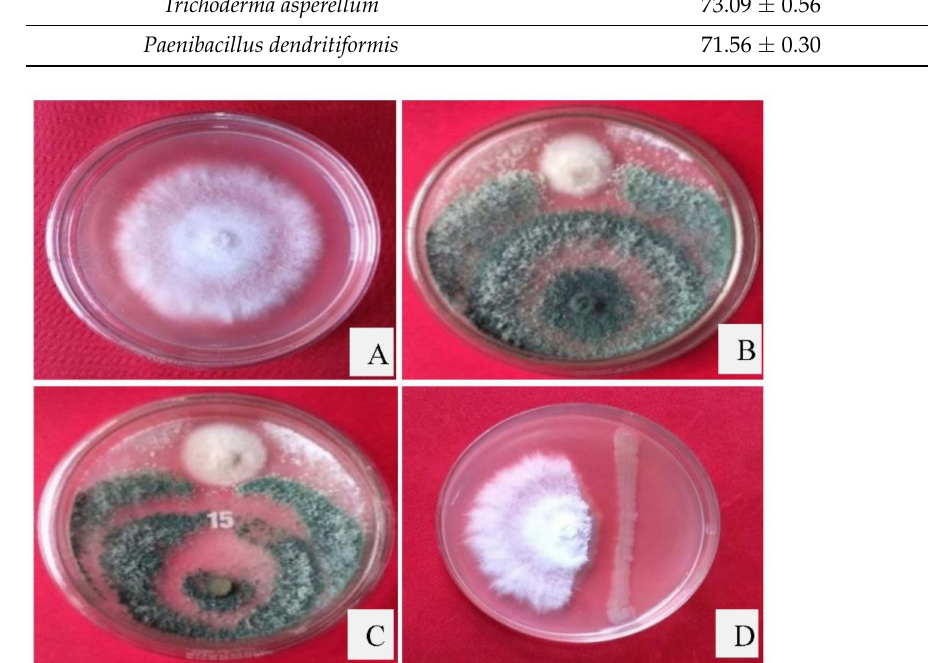
Figure 4. The effects of T. harzianum, T. asperellum, and P. dendritiformis on the inhibition of radial growth of C. truncatum . ( A ) Culture plate of C. truncatum serving as control; ( B ) Antagonistic activity by T.